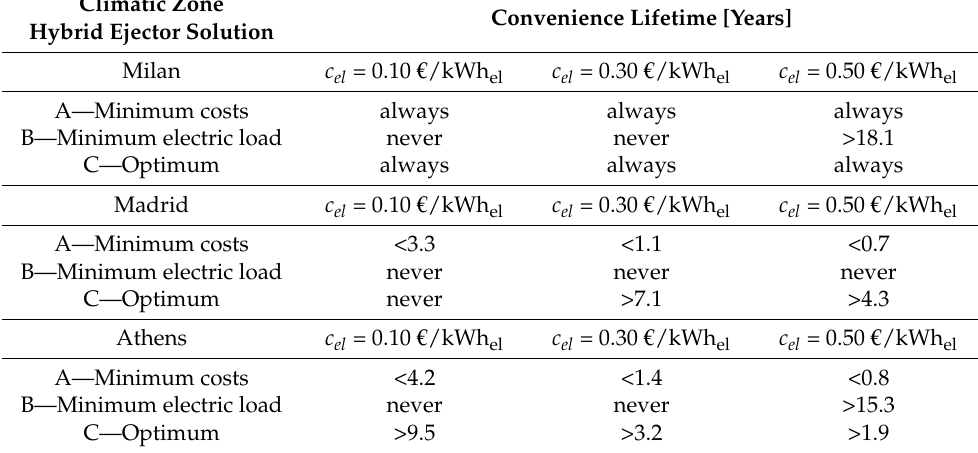
Table 7. Economic life of a hybrid ejector cycle with respect to an electric chiller. Climatic